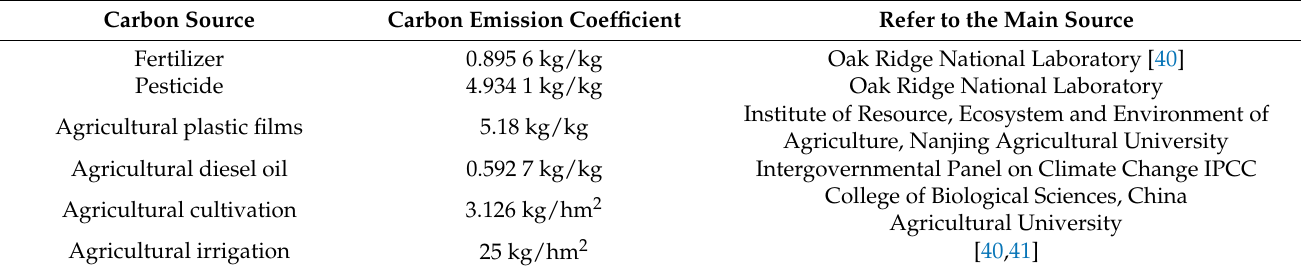
Table 2. Carbon emission coefficient